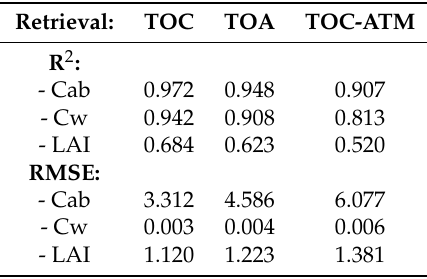
Table 5. Retrieval performance results against 5’000 LUT reference datasets for biophysical variables retrieval from surface reflectance (TOC), TOA radiance (TOA) and surface reflectance with noise levels after atmospheric correction (ATM). For the TOC and TOA retrieval datasets 2% Gaussian noise was added, while for the TOC-ATM retrieval datasets noises are added according to